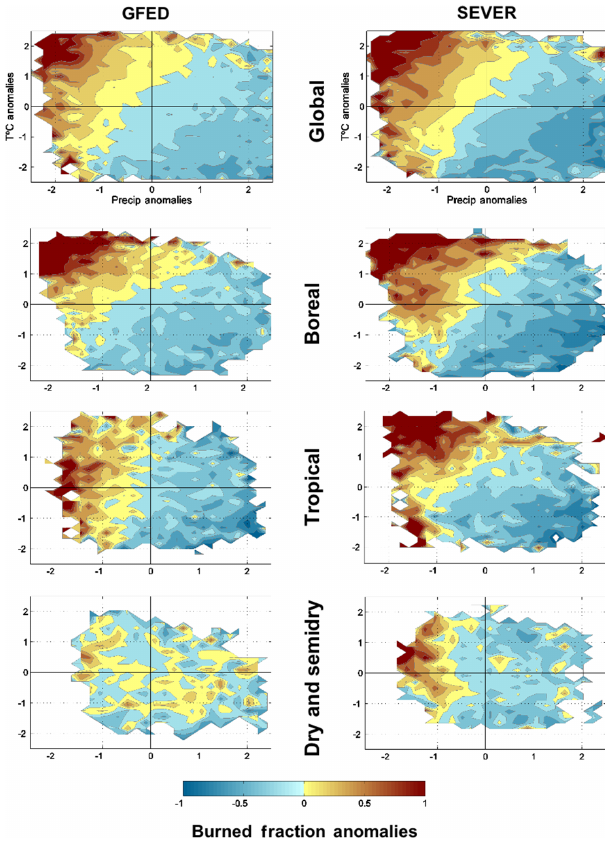
Figure 15. Dependence of fire anomalies on temperature and pre-